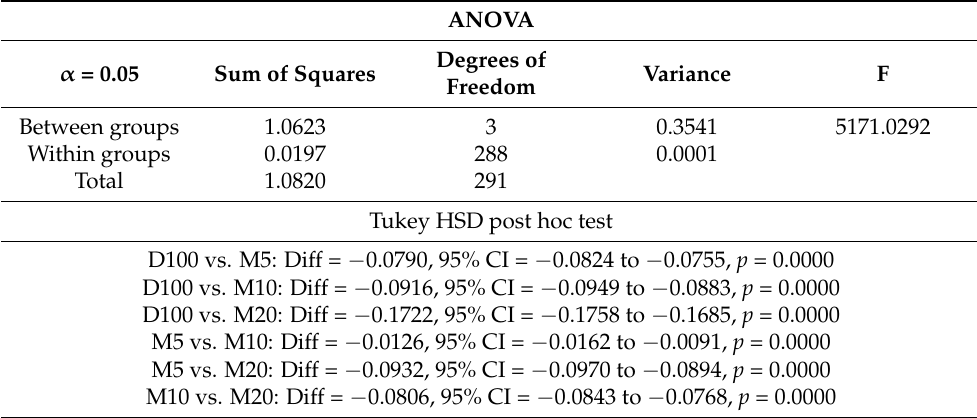
Table 14. Results of ANOVA with Tukey HSD post hoc test for soot particles generation at the measurement point 2.